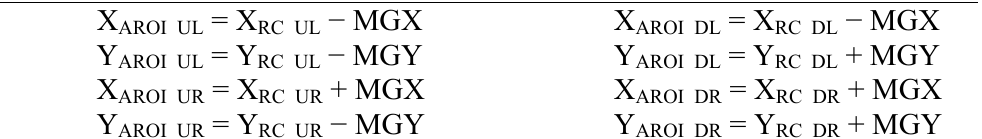
Table 2. Expressions to calculate AROI.